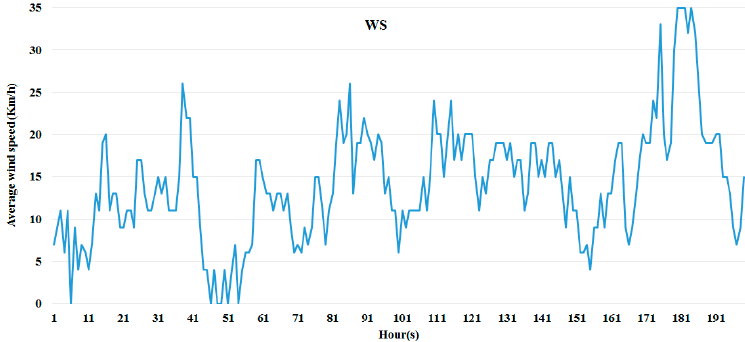
Figure 5. Wind speed data information (km/h).